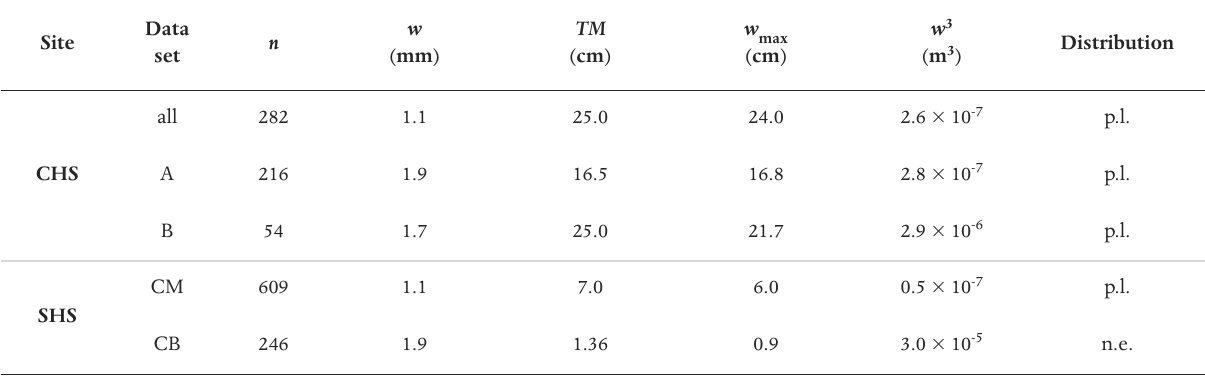
: arithmetic average estimation of veins thickness of a